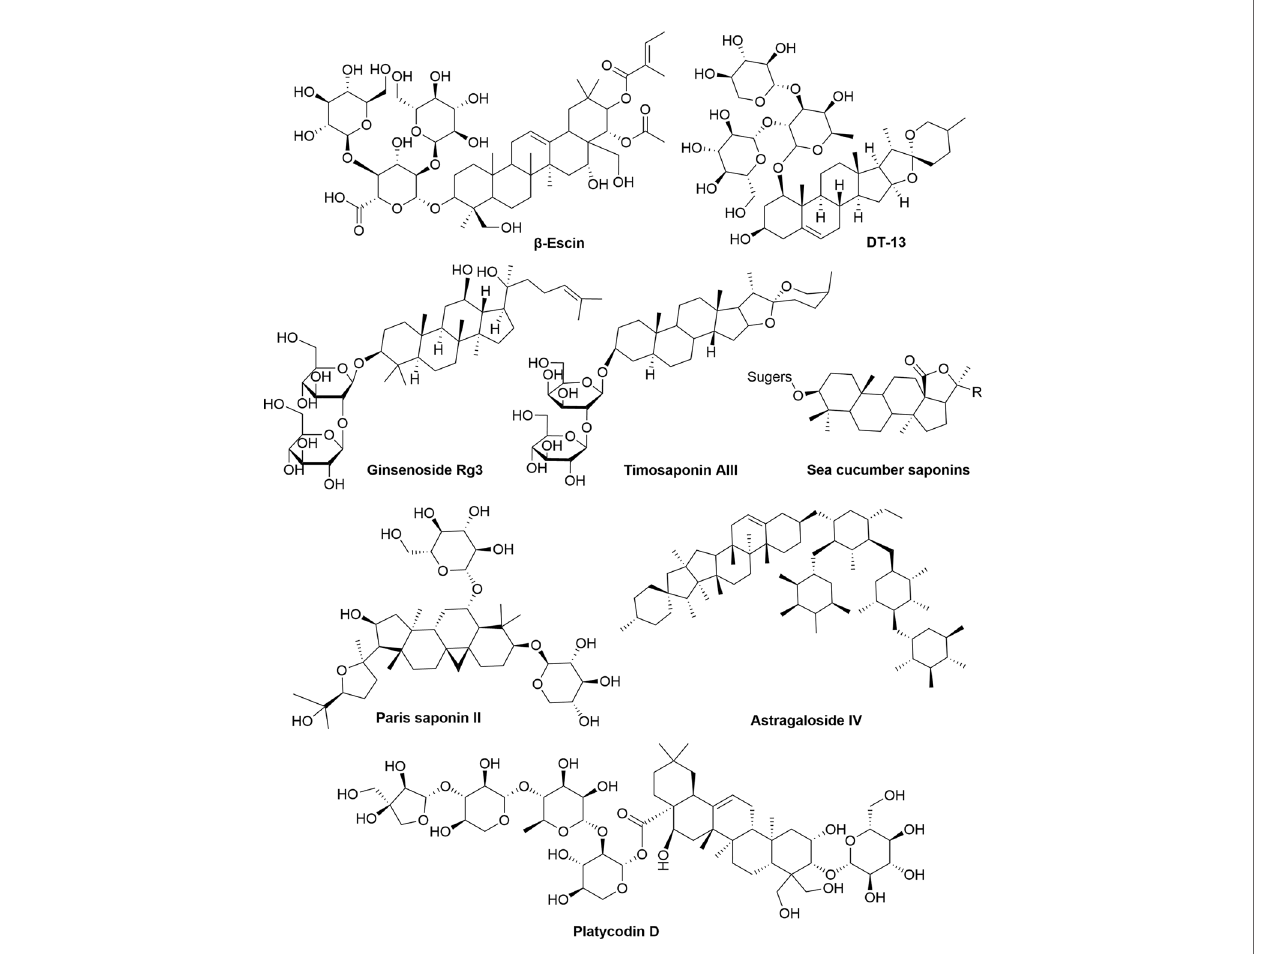
FIGURE 6 | Thechemicalstructuresofsaponins involvedintumorangiogenesis.